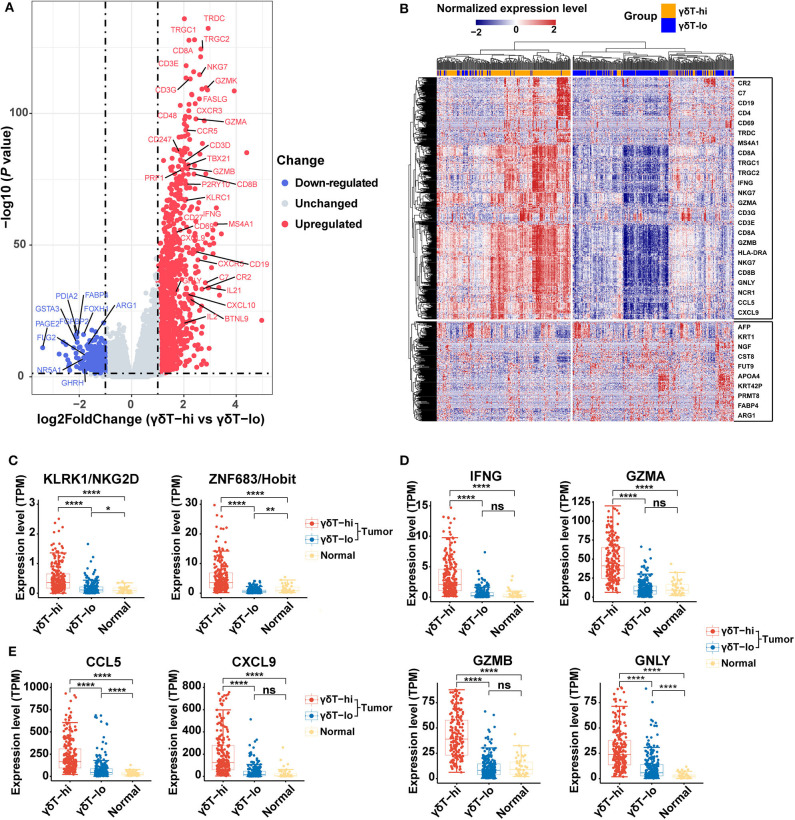
Differentially expressed genes among the γδT-hi, γδT-lo and normal groups in HNSCC using R package DESeq2. (A) Volcano plot of log2 (Fold Change) vs. –log10 (P-value) shows the differentially expressed genes between the γδT-hi and γδT-lo groups. Red points represent the significantly upregulated genes in the γδT-hi group, blue points represent the significantly down-regulated genes in the γδT-hi group (upregulated in γδT-lo group), and gray points represent the genes without significant differences (unchanged). Dotted lines show a P-value of 0.05 (horizontal) and a fold change of ±2 (vertical). (B) Cluster heatmap showing the differential expressed genes between the γδT-hi (orange) and γδT-lo (light blue) groups. All of the expression values of each gene were rescaled to the range from −2 to 2 by Z-Score normalization. The red color in the heatmap indicates the genes that are upregulated, blue color indicates the genes that are down-regulated. Some representative genes were labeled in the boxes on the right side, the upper box contains some representative genes that are upregulated in the γδT-hi group, whereas the lower box contains some representative genes that are down-regulated in the γδT-hi group. (C) NKG2D (KLRK1) and Hobit (ZNF683) expression levels among the γδT-hi, γδT-lo and normal groups. (D) IFNG/GZMA/GZMB/GNLY expression levels among the three groups. (E) Expression levels of chemokines CCL5/CXCL9 among the three groups. Each dot represents the expression value (TPM) of the specific gene in each sample. P-values were calculated by student's t-test. ns, not significant; *P < 0.05; **P < 0.01; ****P < 0.0001.